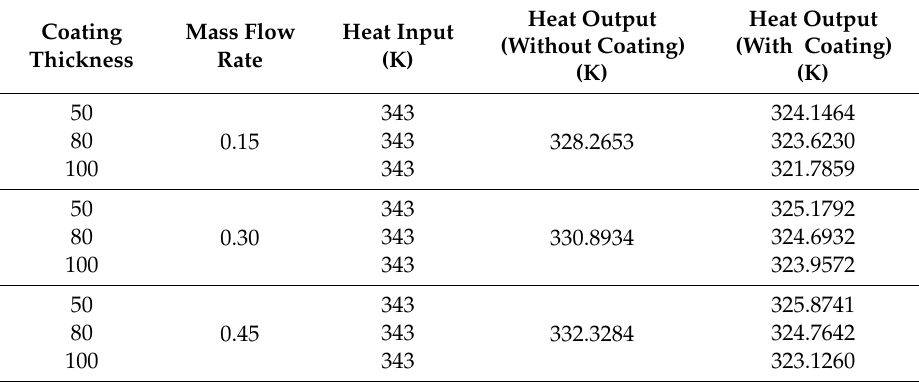
Table 10. CFD Analysis Reading for 343 K.